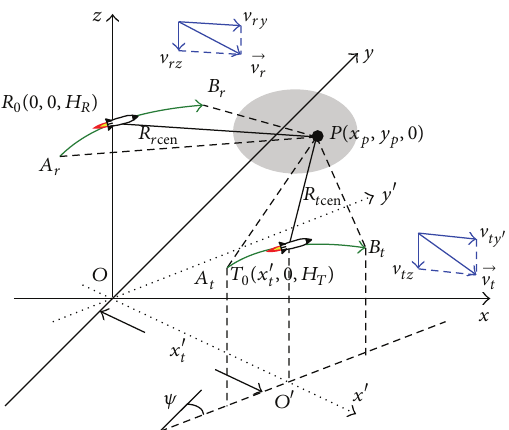
Figure 1: Geometric configuration of